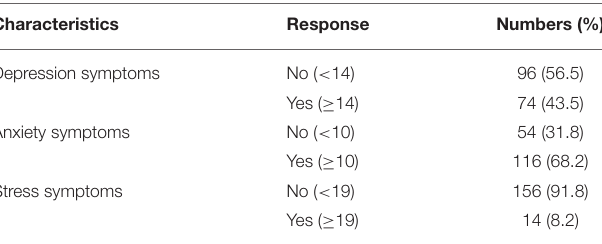
TABLE 1 | Prevalence of DAS in QH employees in